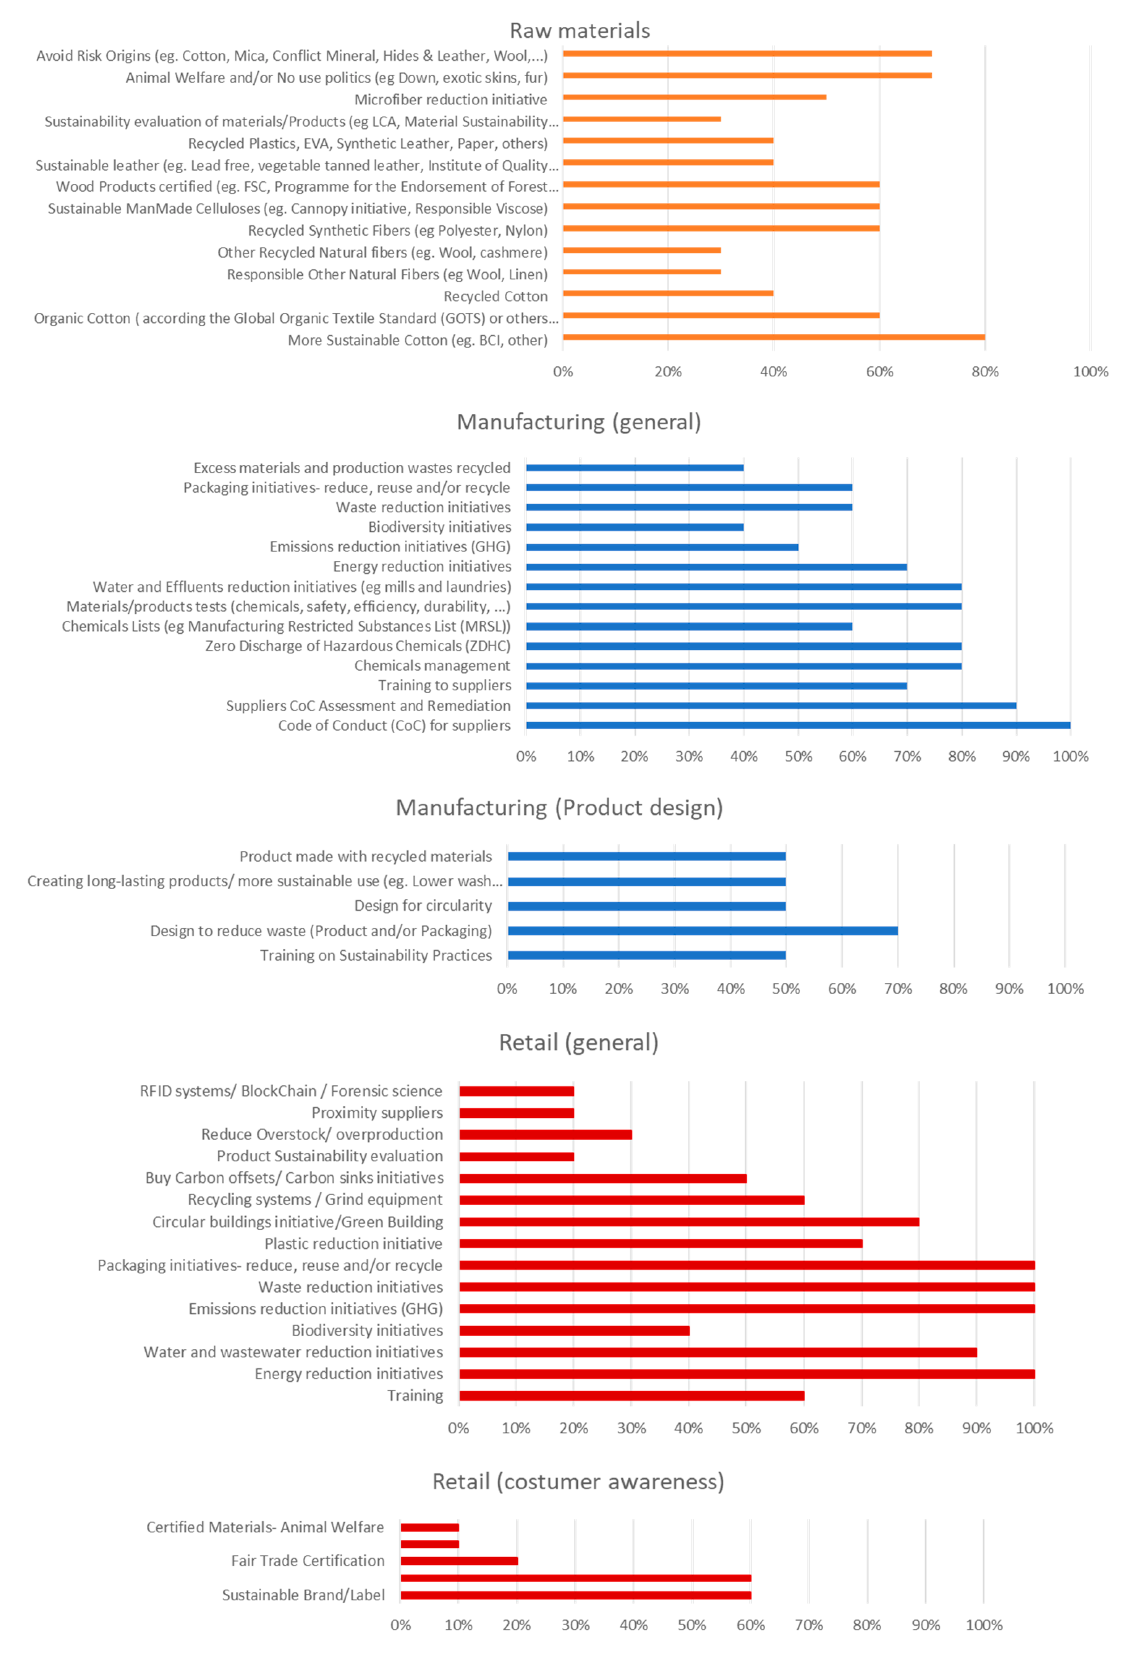
Figure 8. Percentage of top 10 retailers that report about a certain environmental item.